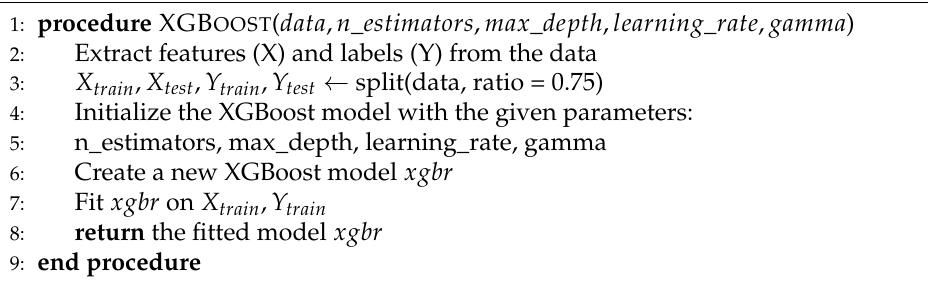
Algorithm 2 XGBoost Regressor.